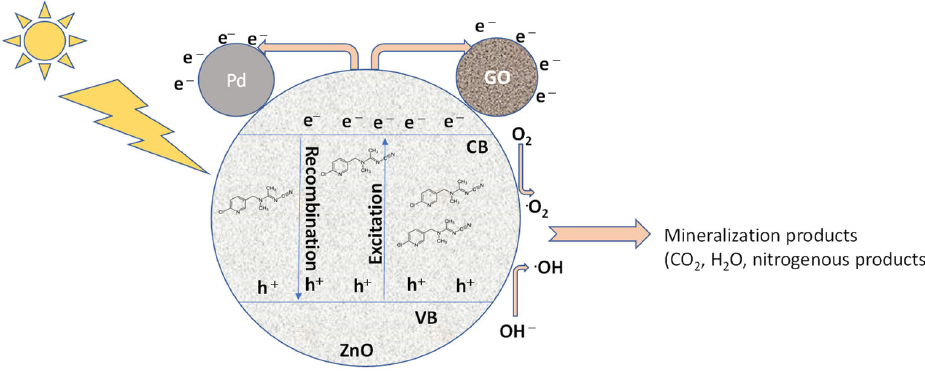
Figure 9. The schematic representation of acetamiprid photocatalytic degradation mechanism in the presence of Pd ‐ GO ‐ ZnO under visible light irradiation.